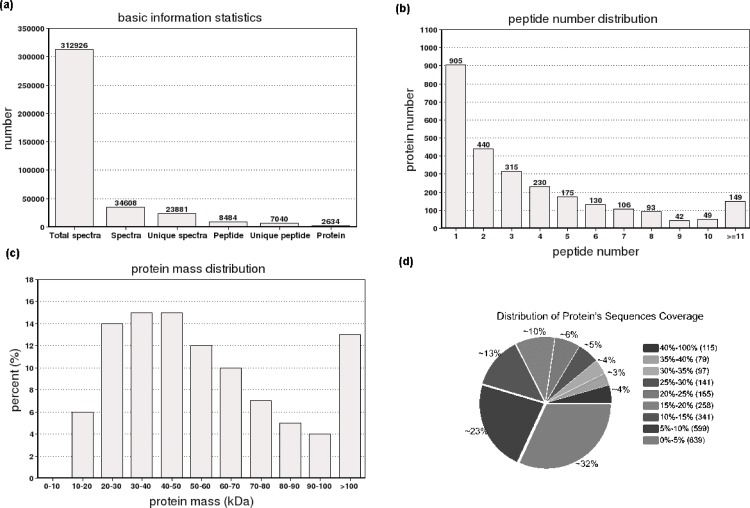
Summary of the iTRAQ-based Paulownia fortunei proteome.(a) Spectra, peptides and proteins that were identified by searching against the Paulownia fortunei transcriptome database; (b) Number of peptides that match proteins using MASCOT; (c) Distribution of the proteins that were identified among different molecular weights; (d) Coverage of the proteins by the identified peptides.